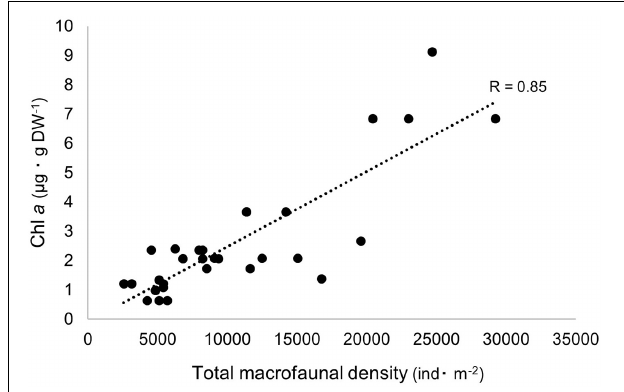
Table includes sequential tests results for each variable: SS (trace) (portion of sum of squares relative to the analyzed predictor variable), Pseudo-F values, p-values, and Prop (proportion of variation explained by each variable), as well as AICc (Akaike Information Criteria corrected), R 2 (proportion of variation explained by the model) and RSS (Residual Sum of Squares) of the best